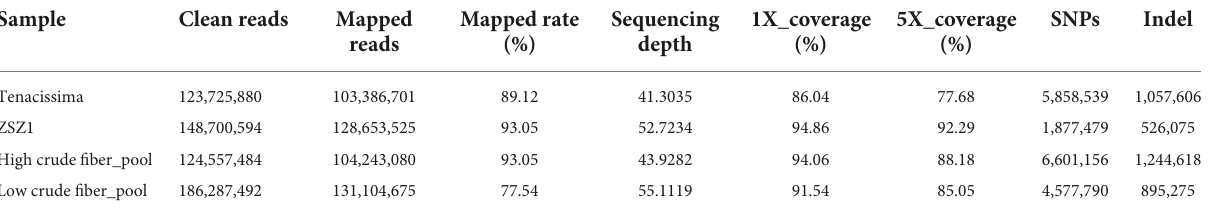
TABLE 2 Summary of data from BSA